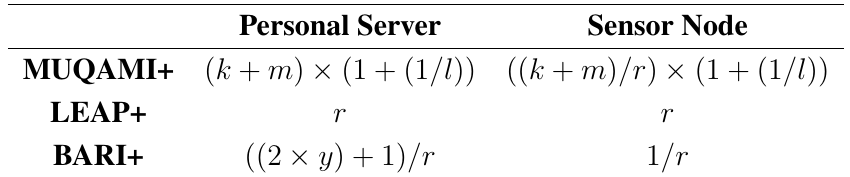
Table 7. Average number of messages transmitted by each type of node when administrative key is refreshed in all three